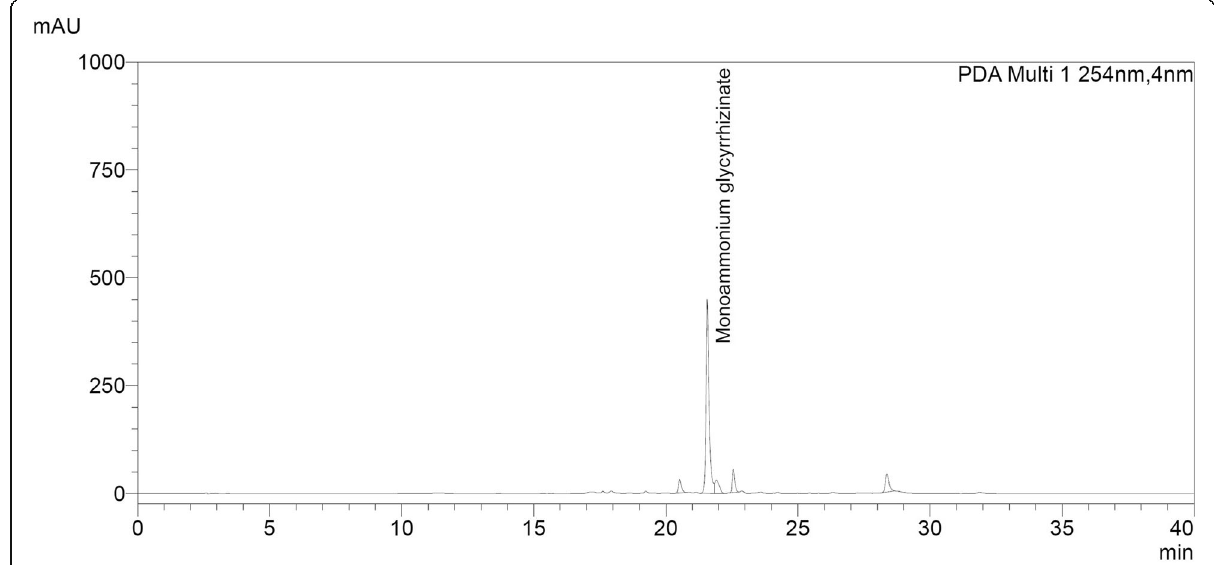
Fig. 6 HPLC chromatogram of monoammonium glycyrrhizinate